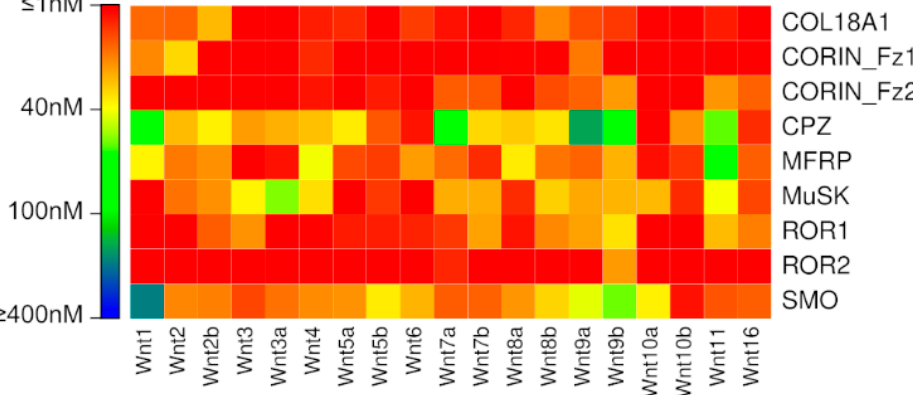
Figure 1. Binding affinities predicted for putative Fzd CRD interactions by the previously published Figure 1. Binding a ffi nities predicted for putative Fzd CRD interactions by the previously published model (Agostino, et al. 2017). model (Agostino, et al.